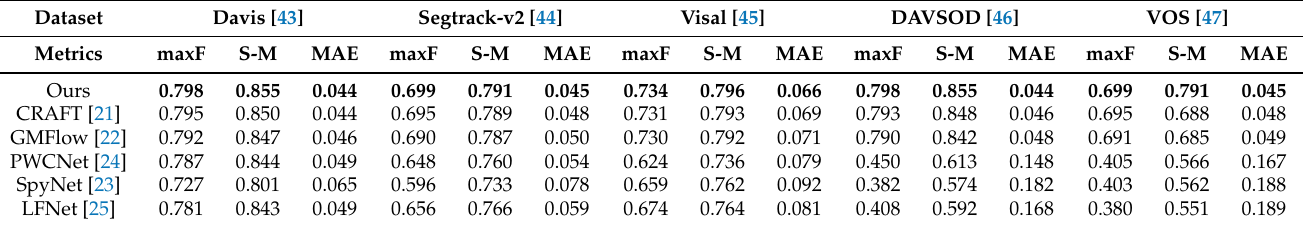
Table 2. Performance comparison of different optical flow models, bold indicates optimal data. “Ours” represents the optical flow model proposed in this